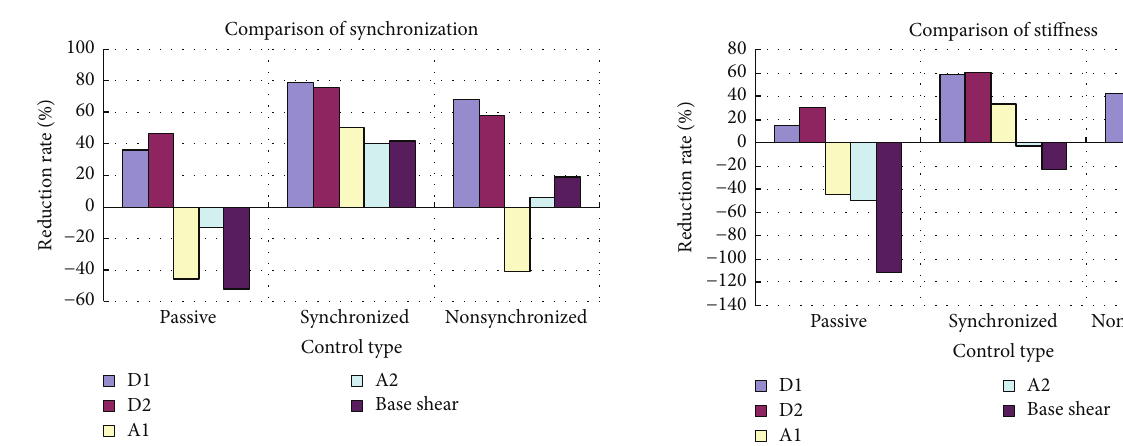
Figure 16: Comparison of shock absorption ratios of the test struc- ture with synchronous and asynchronous control under excitation of the El Centro earthquake.